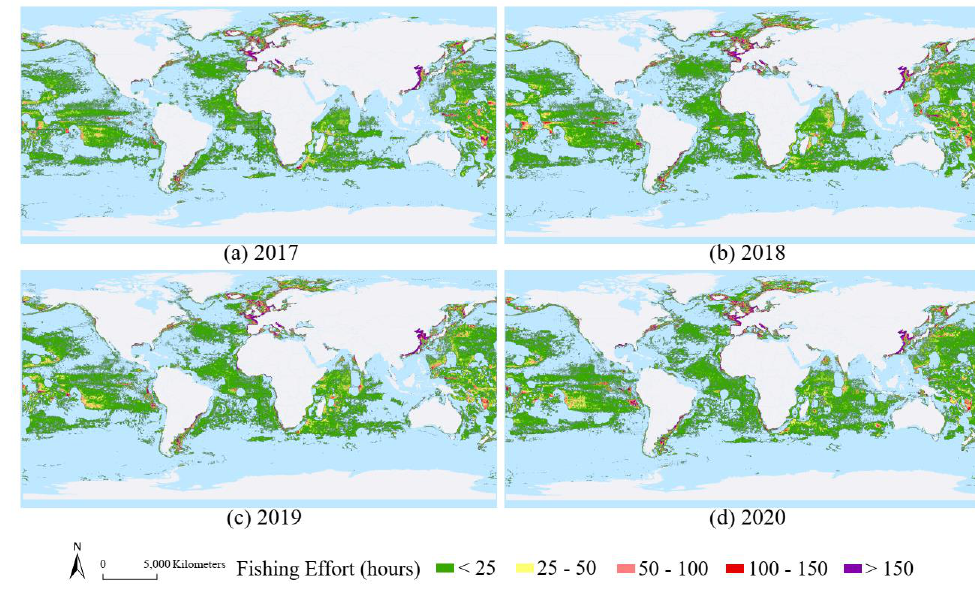
Figure 3. Monthly chain growth of global fishing effort between 2020 and previous year (2017 to 2019). Table 1. Percentage of gridded global ocean area fished in 2017 – 2020. Note that each grid is consid- 169 ered to contain effort regardless of the actual effort (hours) or the number/type of vessels or fishing 170 gear within the grid (see discussion of Kroodsma et al. [22]).